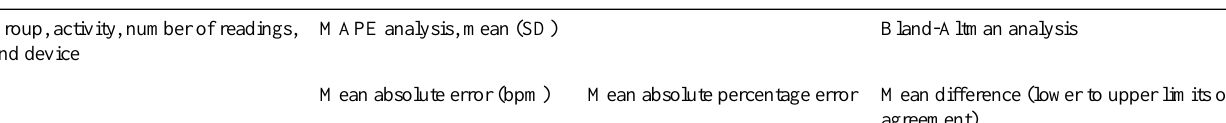
Table 1. Mean absolute percentage error (MAPE) and Bland-Altman analyses of heart rate readings of the Young and Senior groups during different activity